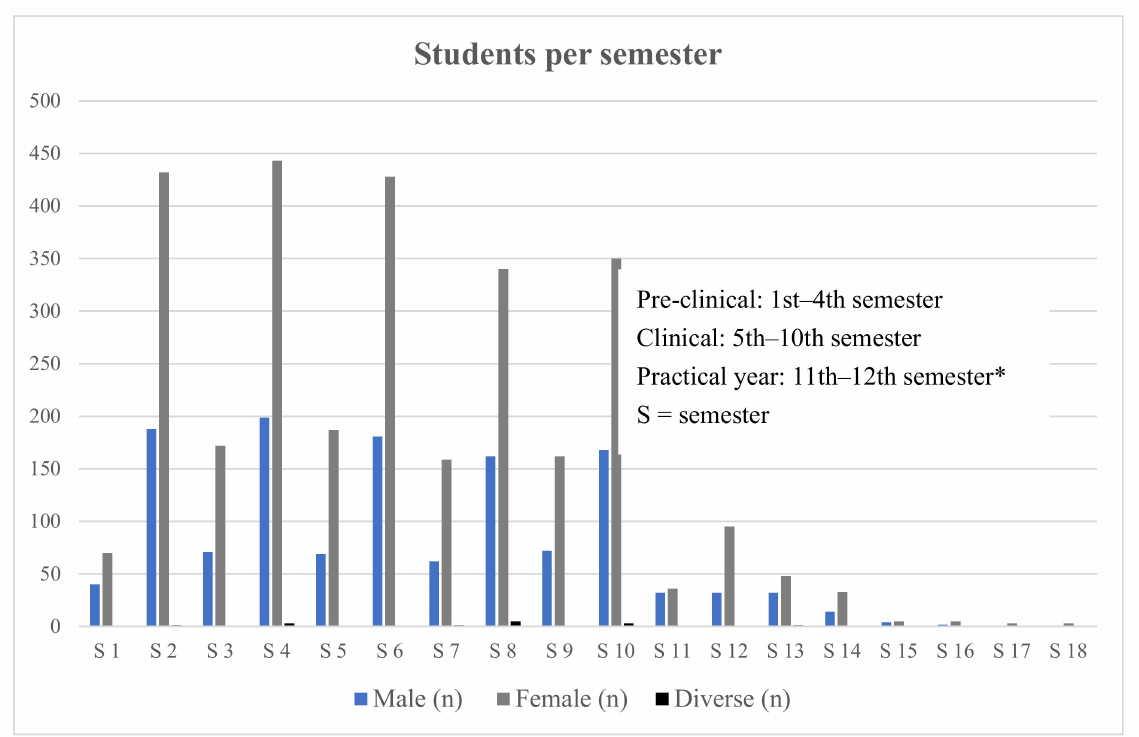
Figure 1. Distribution of medical students enrolled per semester. * Six-year undergraduate medical education in Germany comprises two pre-clinical years and a four-year clinical segment ending with a final practical year. Some students take more time to complete their studies than the official minimum